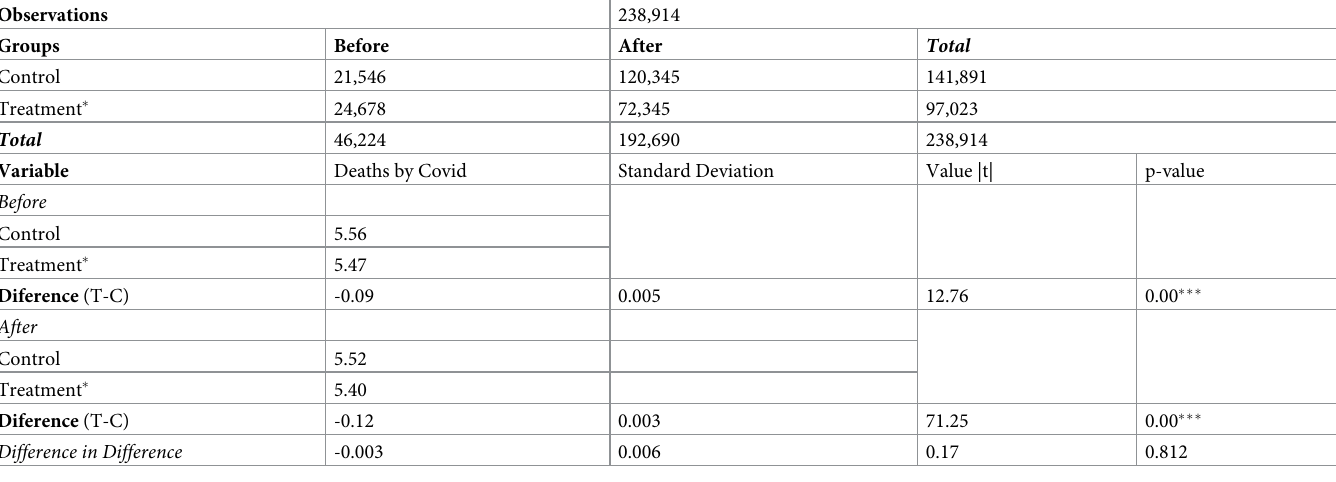
Table 3. DID model results: Testing cost benefit of subsidies to vulnerable